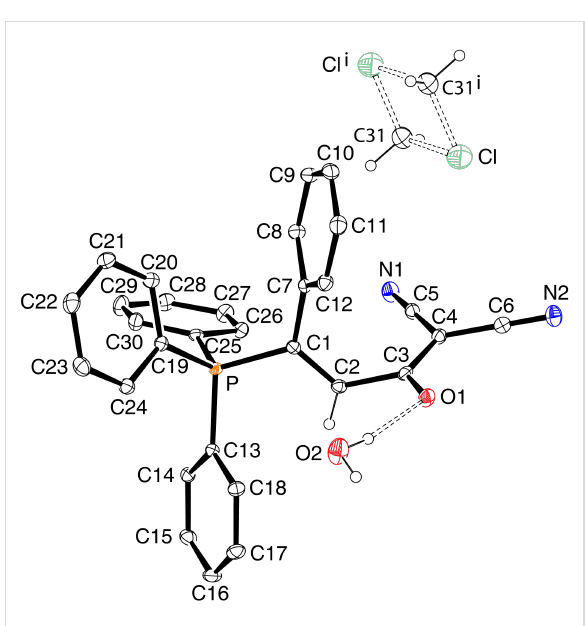
Figure 4: Solid-state structure of E - 3e ·H 2 O·CH 2 Cl 2 (ORTEP plot). The CH 2 Cl 2 solvate molecule is disordered. Hydrogen-bonded H 2 O mole- cule: O1···O2 2.907(2) Å, angle O1···H–O2 169(3)°.